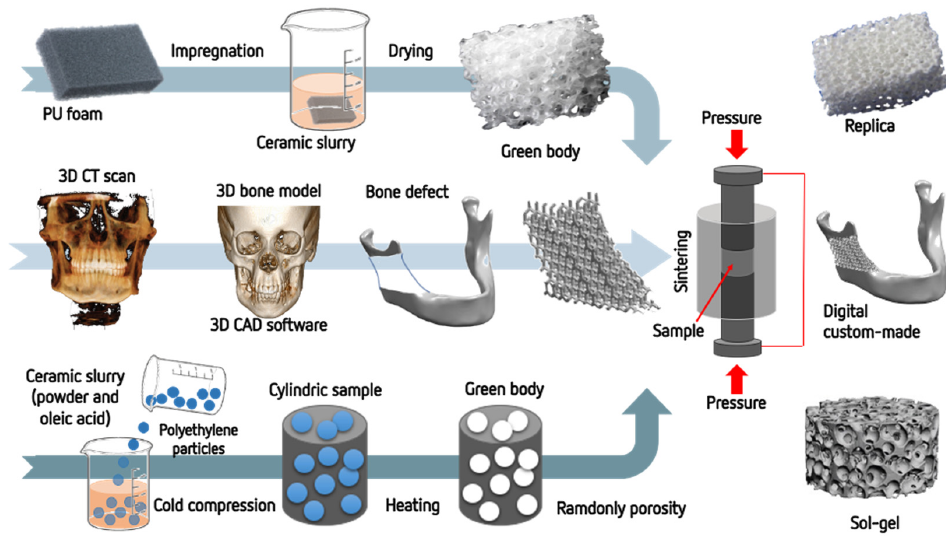
Figure 2. Schematics of the porous zirconia manufacturing.